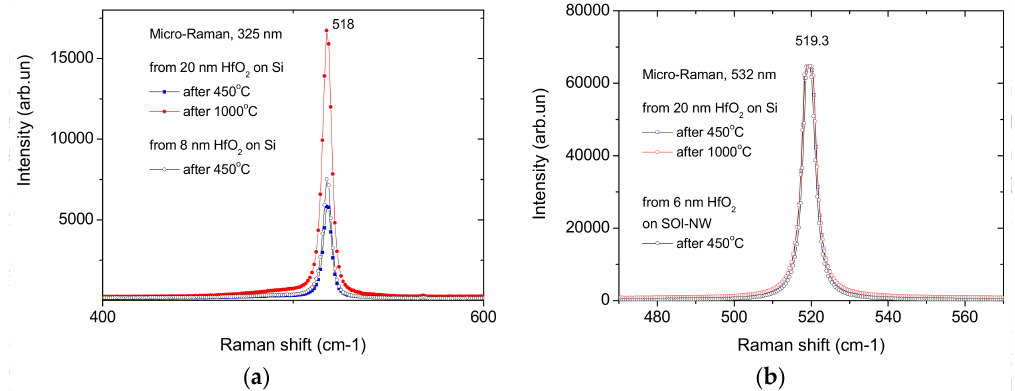
Figure 3. Micro-Raman spectra of single-phonon scattering peak on HfO 2 -coated silicon excited by laser radiation in UV (325 nm) ( a ) and visible (532 nm) ( b ) ranges wafers and SOI-NW chips. Experiment conditions: annealing temperature 450 ◦ C (black and blue lines) and 1000 ◦ C (red lines), HfO 2 layer thickness 20 nm (red and blue lines) and <10 nm (black